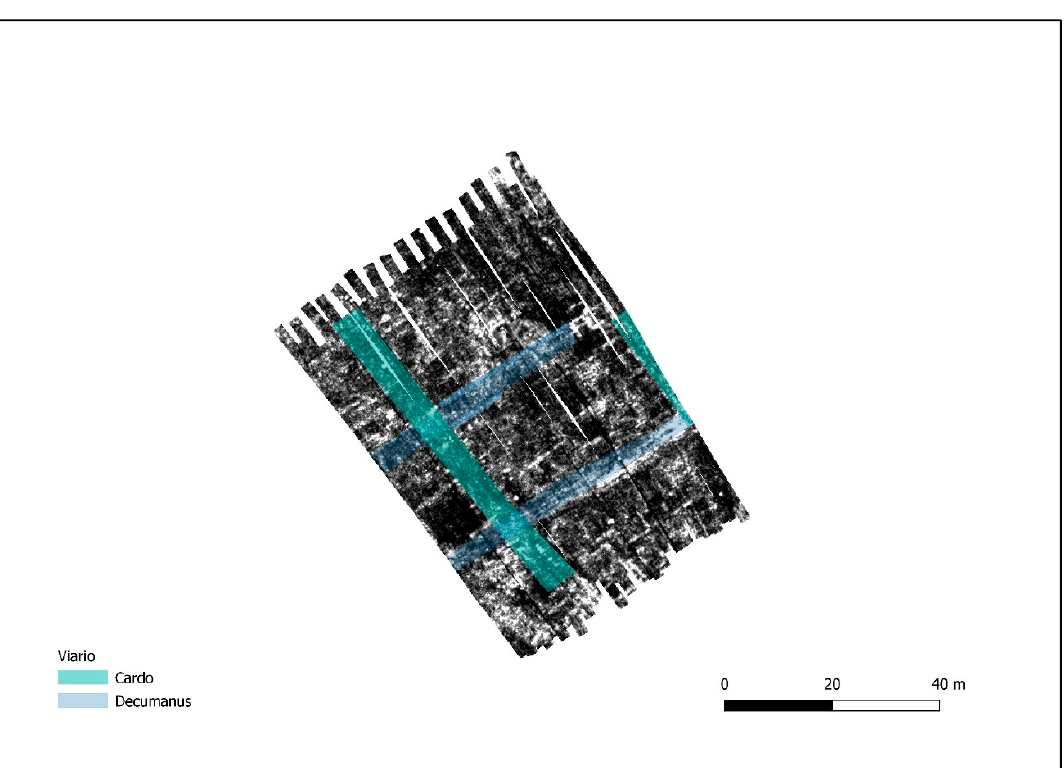
Figure 18. Post-processing of project 3 and road representation.